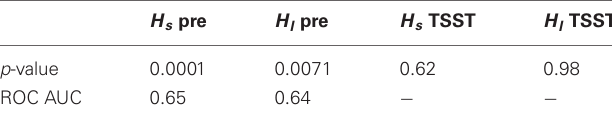
Table 2 | Statistical tests on H s and H l before and during the